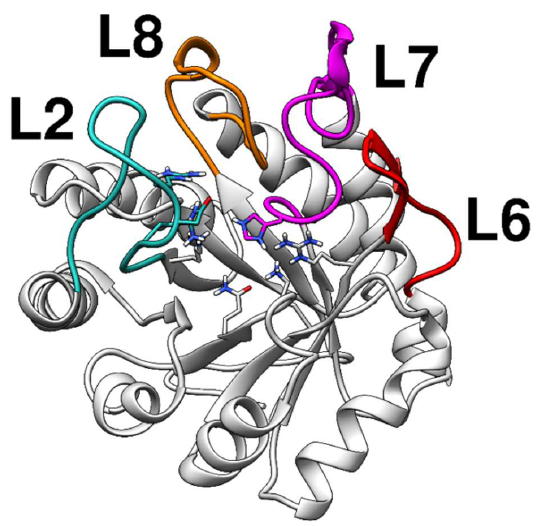
Figure 1. Structure of the modeled KDO8P synthase from Neisseria meningitidis evidencing the regions of the loops. The loops, L2, L7, and L8, control access to the active site. After building the model, the structure was validated through di ff erent